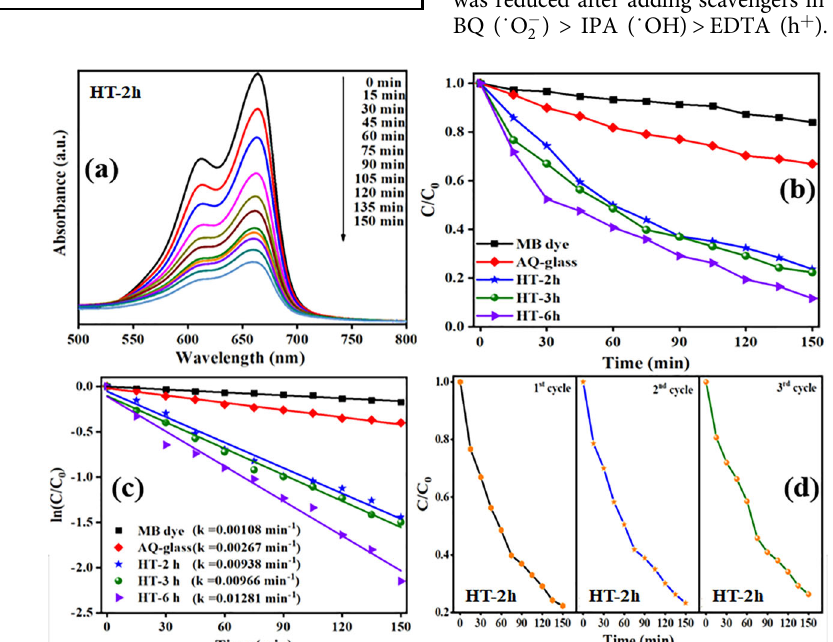
Fig. 6 Piezocatalytic MB dye degradation performance. a Decreasing intensity of characteristic peak of MB dye while performing piezocatalysis using HT- 2h sample. b , c Piezocatalysis results in terms of C vs. time plots and the kinetic rate of dye degradation obtained using all samples under study, and C 0 d repeatability of piezocatalytic capability of HT-2h sample. All results indicating the promising piezocatalytic dye degradation capability of HT-2h